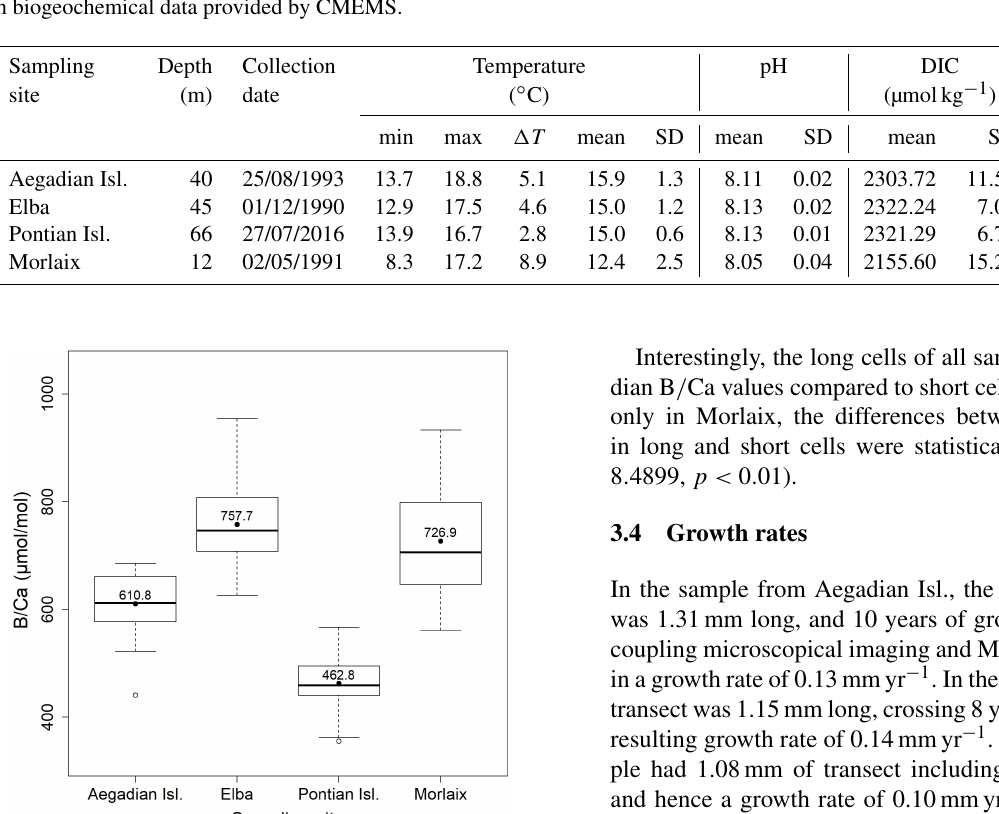
Table 1. Environmental data from each sampling site. The minimum and maximum monthly means of temperature are indicated, as are the highest temperature variation ( (cid:49)T ), the mean, and the standard deviation of the time series. Data from monthly means were extracted by 11 years of ORAS5 reanalysis. The pH and DIC for each sampling site are also indicated. The minimum, maximum, mean, and standard deviation values have been measured over the time interval 1999–2017. Carbonate system parameters have been extracted from monthly mean biogeochemical data provided by CMEMS.